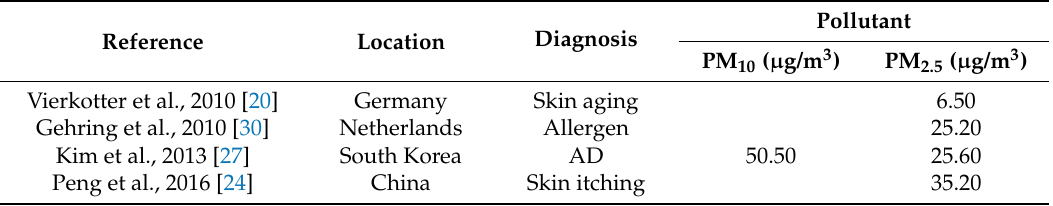
Table 5. Relationship between PM concentration and human skin diseases over long-term